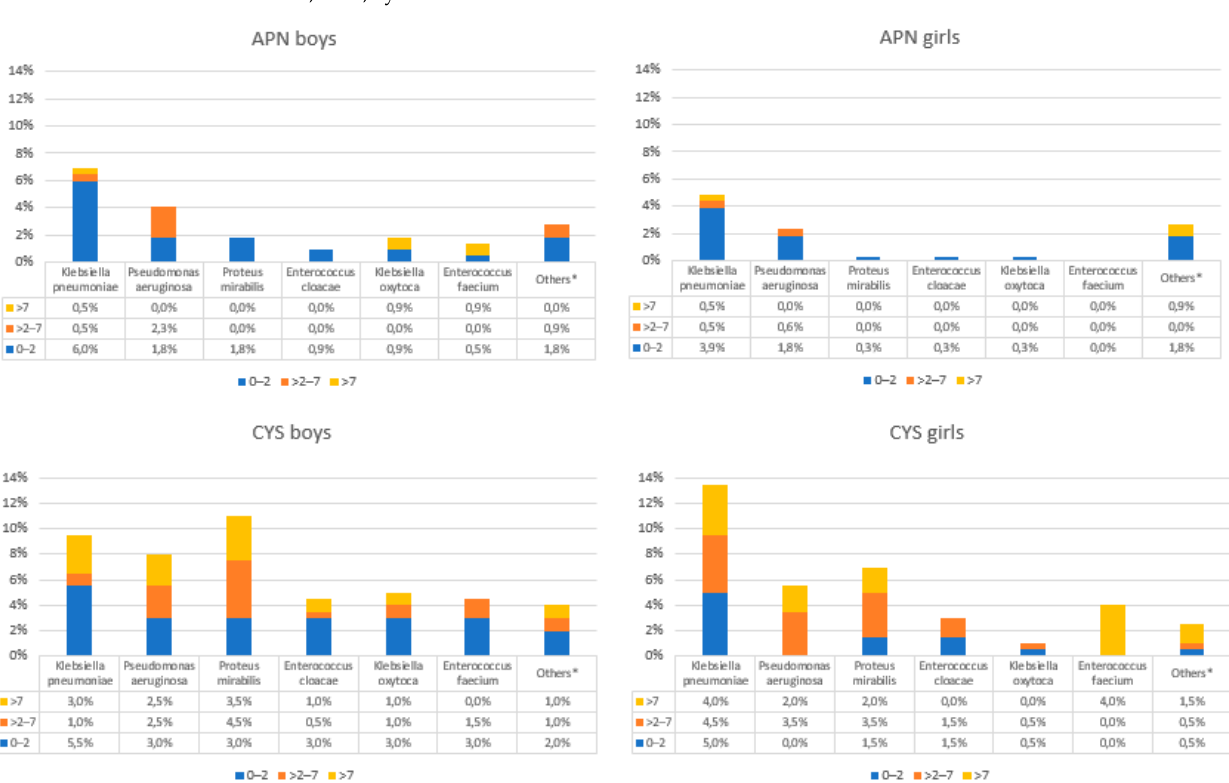
Figure 4. Distribution of bacterial strains according to sex, age, and type of UTI. APN; acute pyelonephritis, CYS; cystitis. * Acinetobacter baumanii , Acinetobacter Iwofii , Citrobacter freundii , Enterobacter kobei , Klebsiella variicola , Morganella morgani , Providencia stuartii , Staphylococcus aureus , Staphylococcus saphrophyticus , Serratia fonticola , Serratia marcensces , Raoultella ornithinolytica , Raoultella planticola The most frequently isolated bacterial strains were E. coli , K. pneumoniae , Ps . aeru- ginosa , Enterococcus spp, and P. mirabilis , both in patients without risk factors (84.5%; 6.7%; 3.0%; 1.5%, and 0.9% respectively) and in patients with risk factors (59.8%; 11.5%; 7%; 6.3%, and 8.5%, respectively), Figure 5.